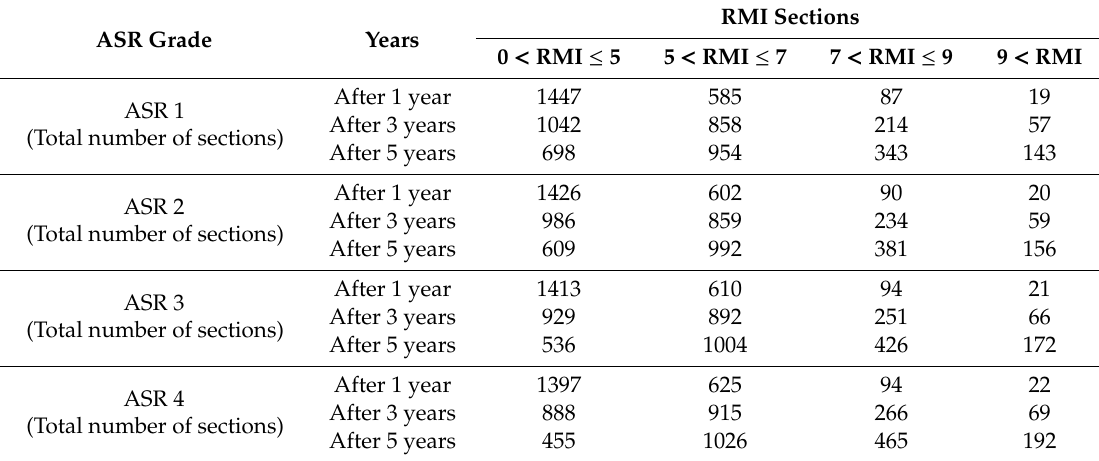
Table 3. ASR grade and number of RMI sections 1, 3, and 5 years into the